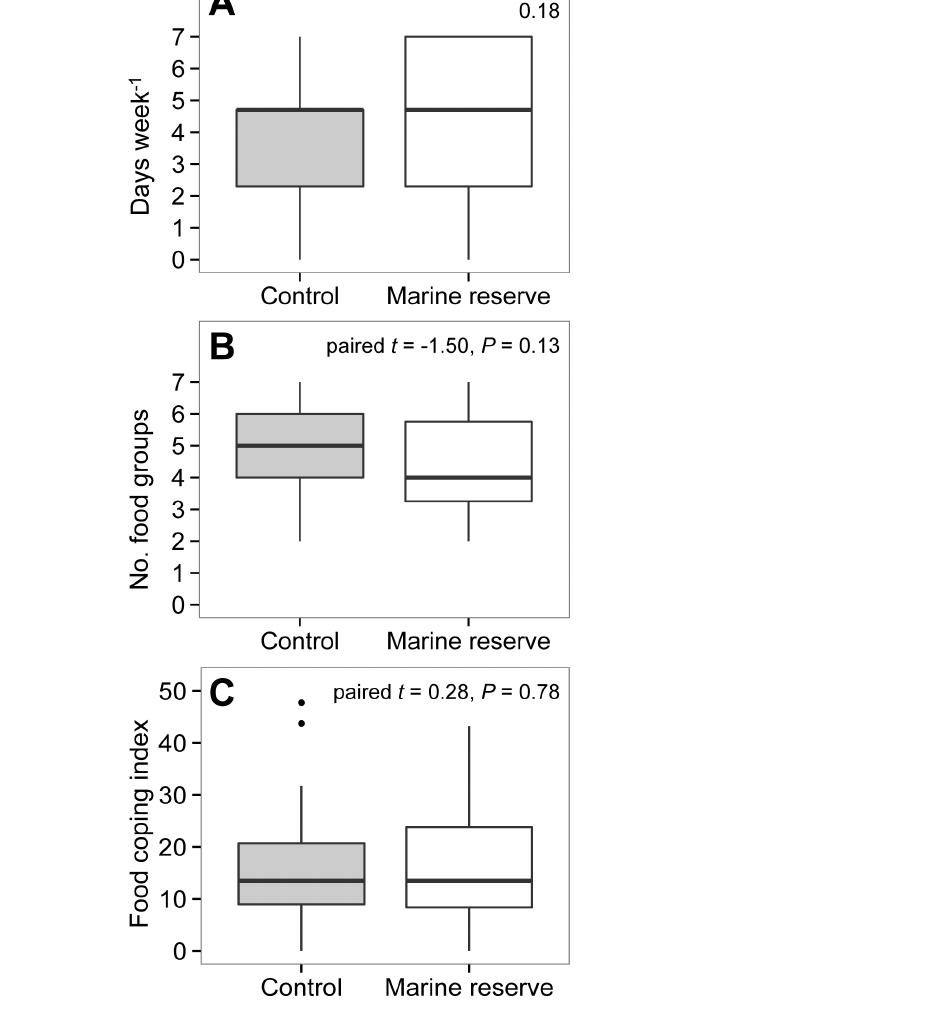
Figure 2. Comparisons of (A) protein consumption, B) diet diversity and C) food coping strategies between households near and far from marine reserves in Kenya (n 5 54 pairs of households matched on household size, number of jobs, fortnightly expenditures and wealth). Paired t -tests are given for each